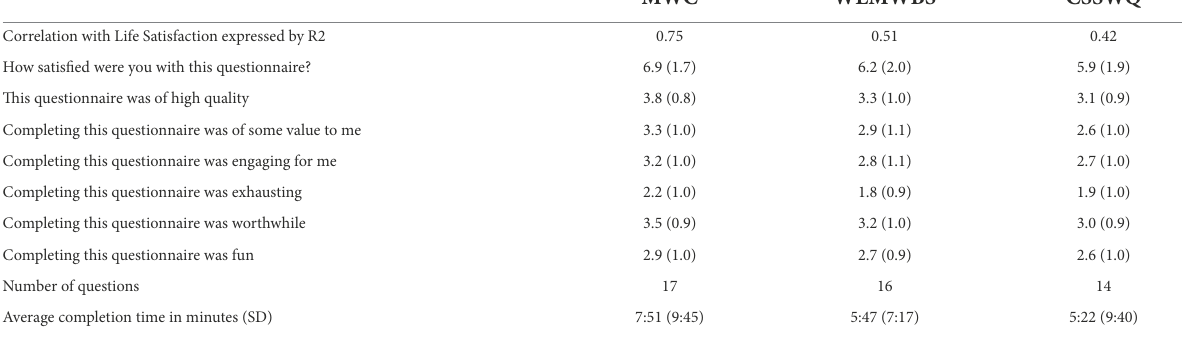
TABLE 6 An overview of the experimental results during iteration four.